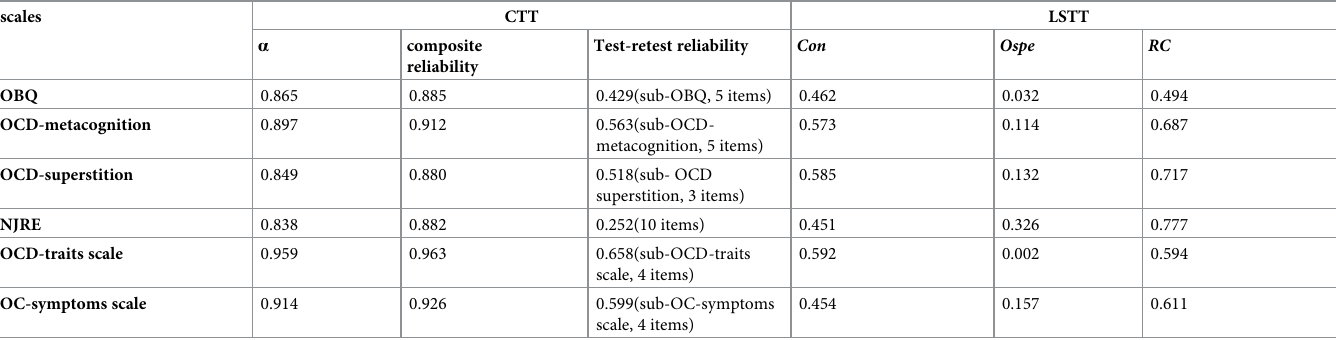
Table 5. Six-scale reliability index (based on two types of models).